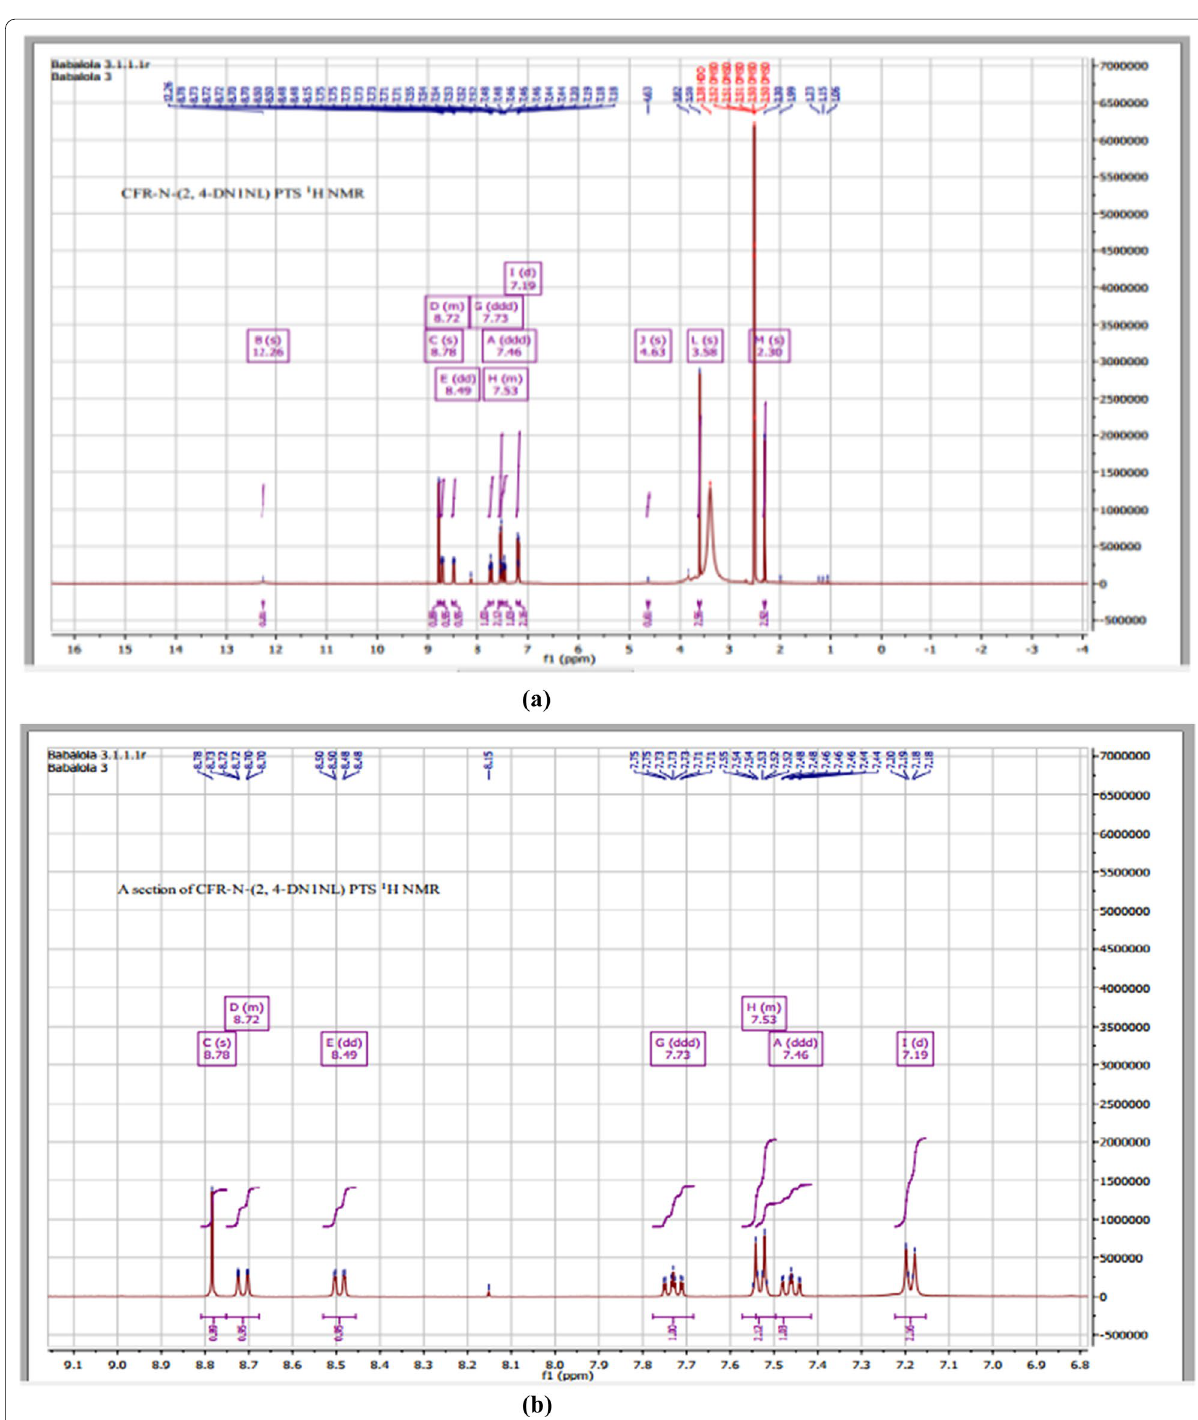
Fig. 9 a The 1 H NMR of the formed complex, {CFR-N-(2,4-DN1NL) PTS} in deuterated dimethylsulphoxide. b A section of the 1 H NMR of the formed complex, {CFR-N-(2,4-DN1NL) PTS} in deuterated dimethylsulphoxide. c A section of the 1 H NMR of the formed complex, {CFR-N-(2,4-DN1NL) PTS} in deuterated